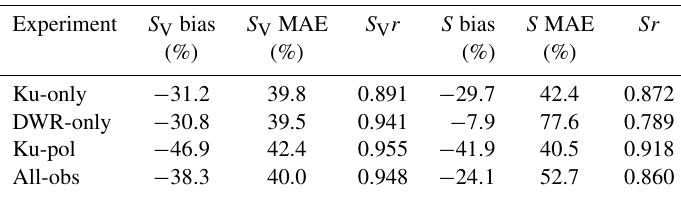
Figure 11. Time series of D3R- and PIP-derived snow water equivalent rate (a, b, c) and accumulation (d, e, f) for each event. Because the PIP calculations involve a variety of assumptions to derive particle mass from shape and fall speed (Tokay et al., 2022), a range between the minimum and maximum from these calculations is shaded around the mean PIP-derived value. Table 7. Mean bias, MAE, and correlation coefficient ( r ) of PIP-derived versus D3R-estimated volumetric snowfall rate ( S V ) and snow water equivalent rate ( S ) for each of the four retrieval experiments, compiled over all three events when the D3R-observed Ku-band reflectivity was within the PIP-simulated Ku-band reflectivity range. Because of the wide dynamic range of snowfall rates, these quantities are expressed as percentages relative to the mean PIP